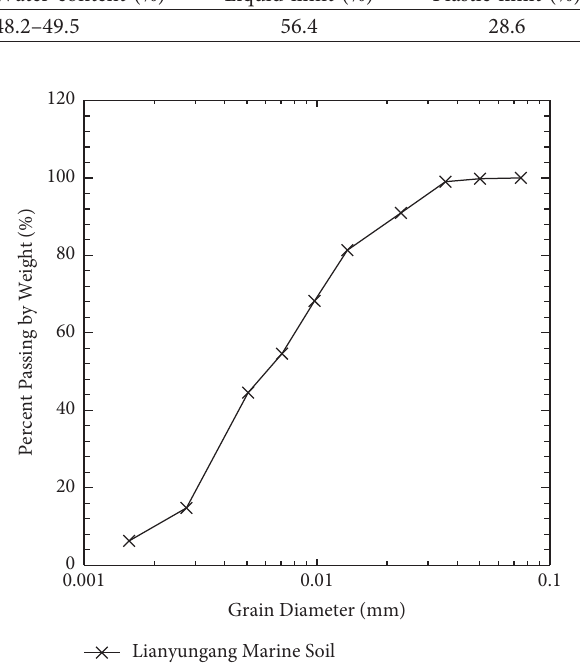
Figure 1: Grain size distribution of Lianyungang marine